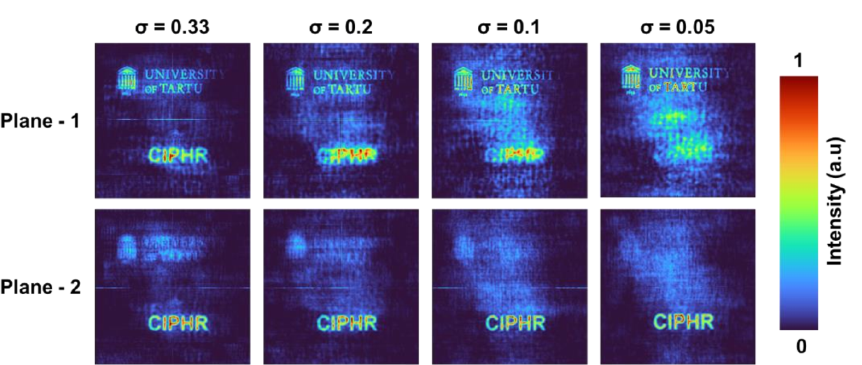
Figure 5. Images of PSFs and the imaging results of the two planes with two test objects for FZP and diffractive axicon.